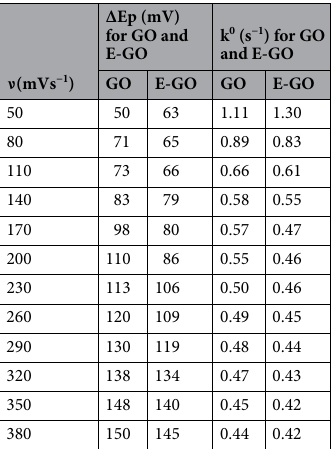
Table 1. Variation of some of the parameters derived from Fig. 7, heterogeneous rate constant (k 0 ) as a function of potential sweep